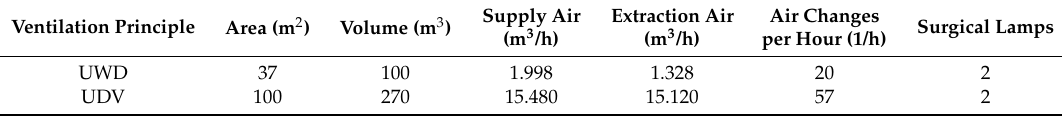
Table 1. Technical data of evaluated OTs: four with UWD and one hybrid with UDV ventilation.